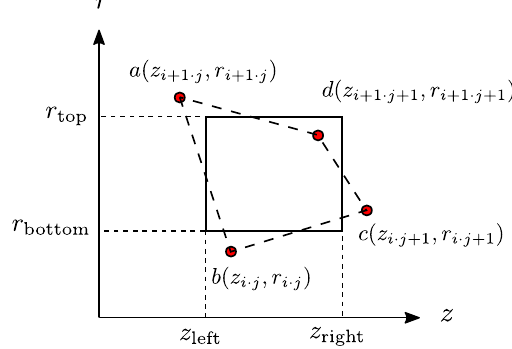
FIG. 2. Longitudinal section of a hollow cylinder used in the new code.